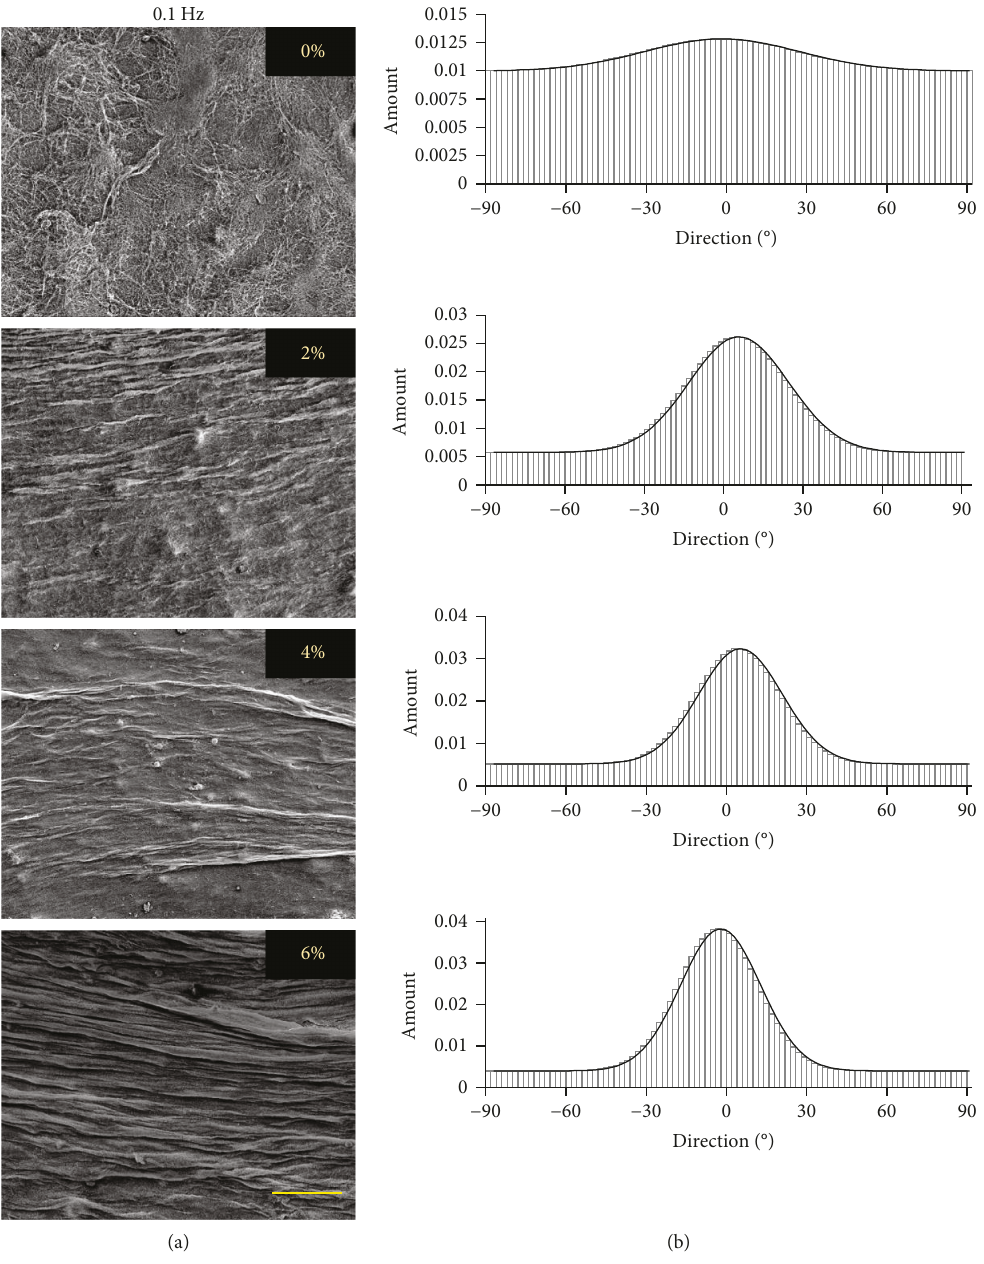
Figure 2: E ff ect of uniaxial tensile loading at 0.1Hz frequency on matrix organization of ASC-encapsulated 3D collagen sca ff olds. (a) SEM images and (b) directionality histograms of ASC-seeded collagen constructs subjected to 7 days of uniaxial loading at 0%, 2%, 4%, and 6% strains at 0.1Hz frequency. Scale bar in the image represents 100 μ m. Sharper and higher peak in the histogram demonstrates a higher degree of orientation of the fi bers. The matrix orientation is parallel to the axis of tensile load